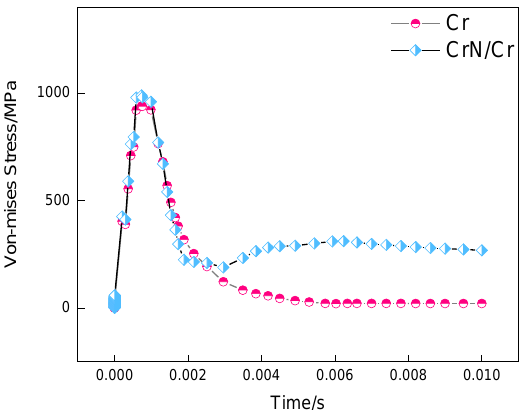
Figure 11. Variation curves of maximum stress at the interface between Cr coating and CrN/Cr composite coating and gun – steel matrix with gun firing time.